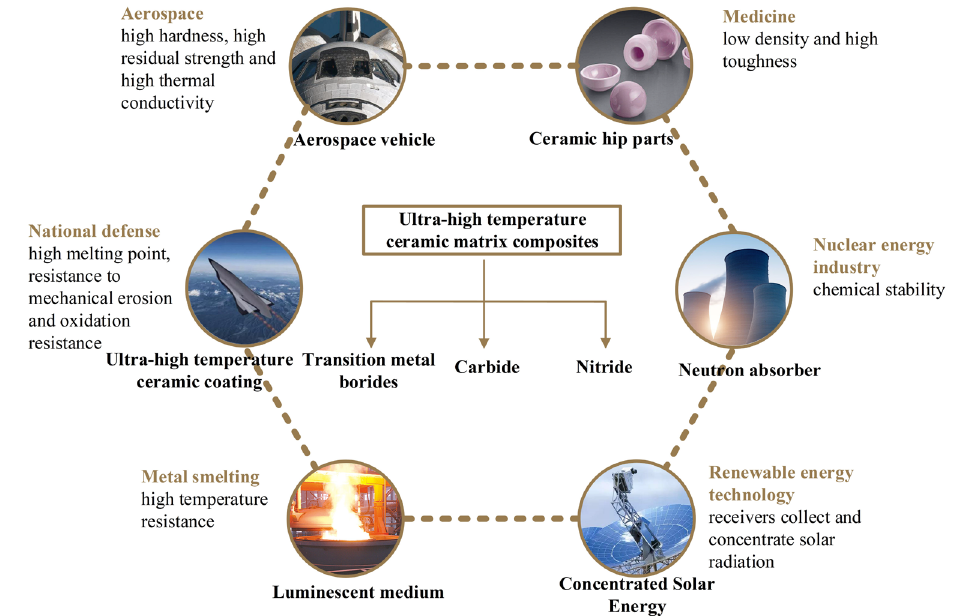
Figure 1. Characteristics and applications of UHTCMCs.